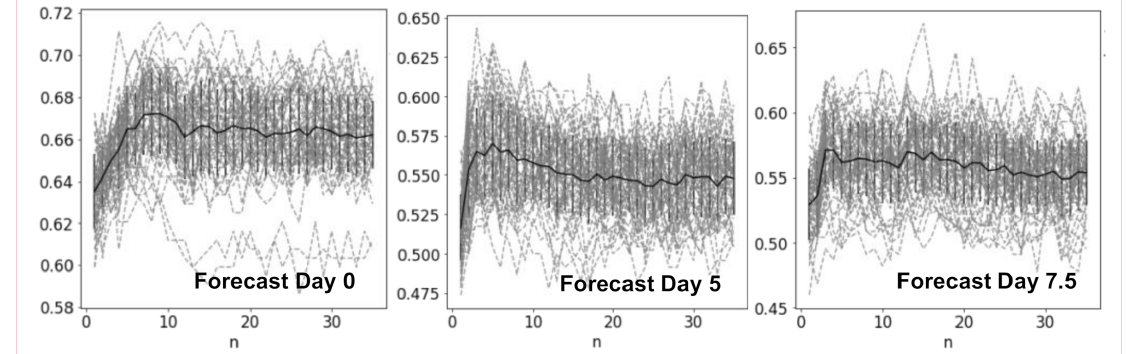
Figure 9. Accuracy of the model as a function of the number of features ( n ). Each grey dashed line represents a sample, while the black solid line shows the samples’ average for each n . The three forecast times, 0, 5 and 7.5 days are indicated in the